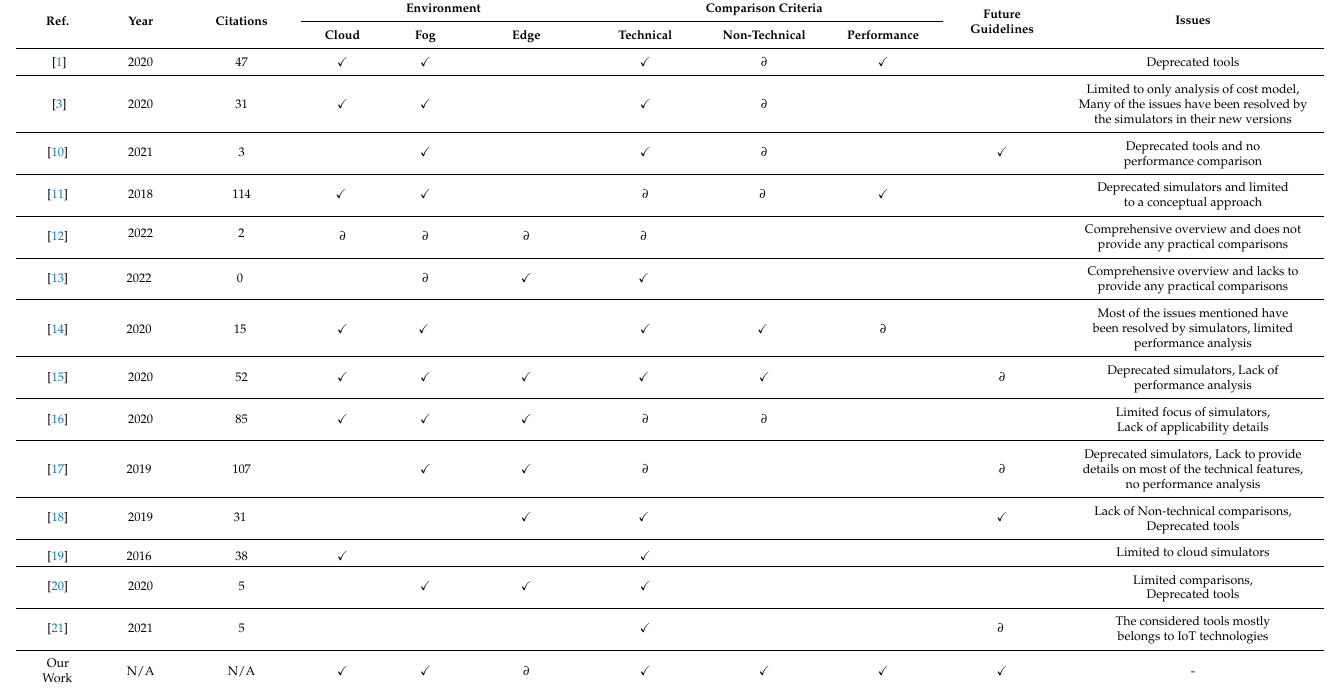
Table 1. Related